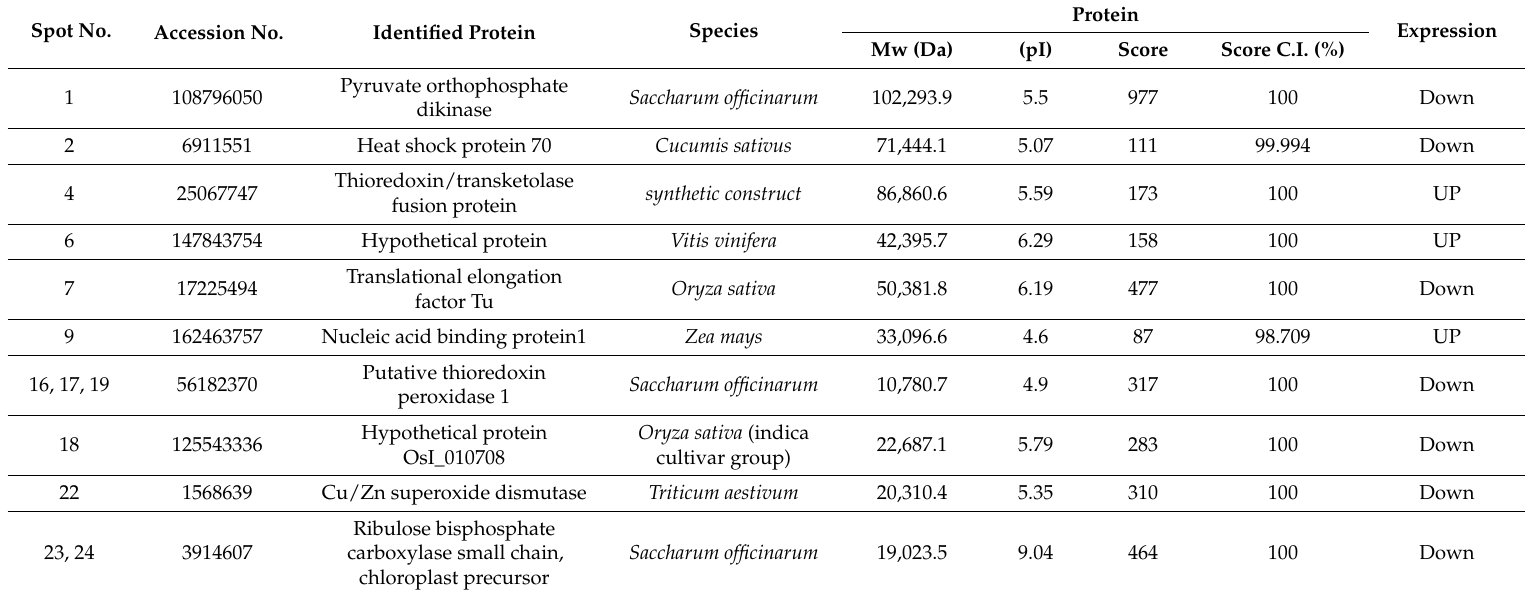
Spot numbers matched up to 2-DE gel in Figure 1; Expression relation was measured comparative to protein expression in control